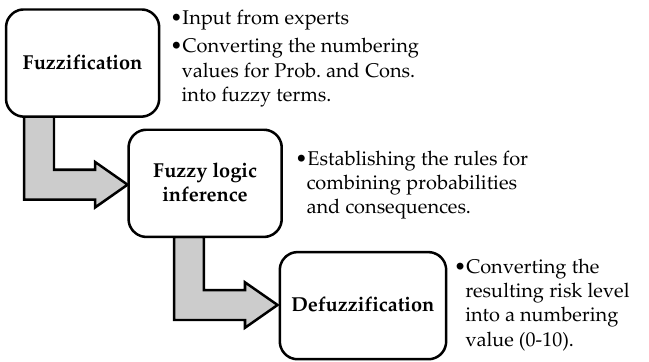
Figure 2. Overview of the fuzzy logic process.